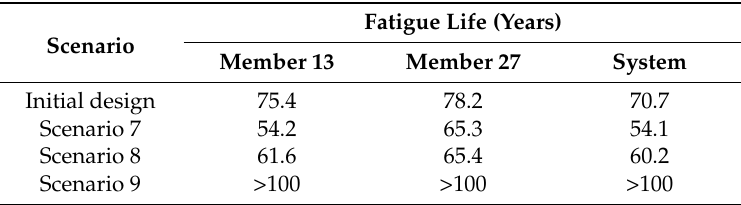
Table 6. Fatigue lives for mixed cases (Scenarios 8 and 9 in Table